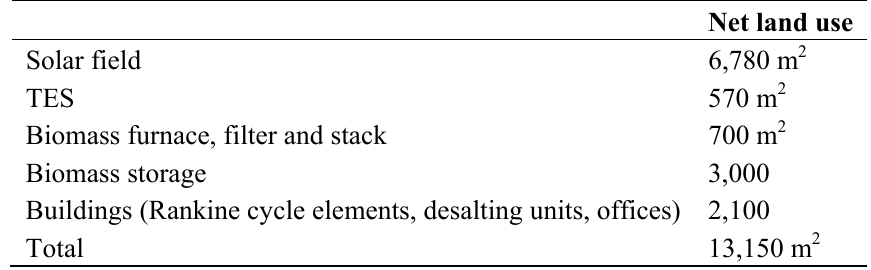
Table 6. Plant land